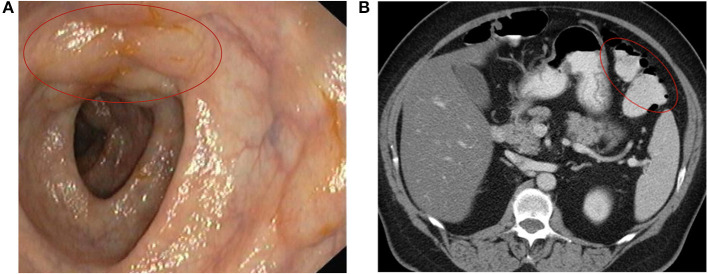
Pretreatment images of a 59-year-old woman with PCI that underwent HBOT at our centre (69) (A) PCI's endoscopic image of subepithelial nodular elevations covered with mucosa of normal appearance (B) Abdominal computed tomography showing gas-filled cysts in the splenic flexure of the colon.